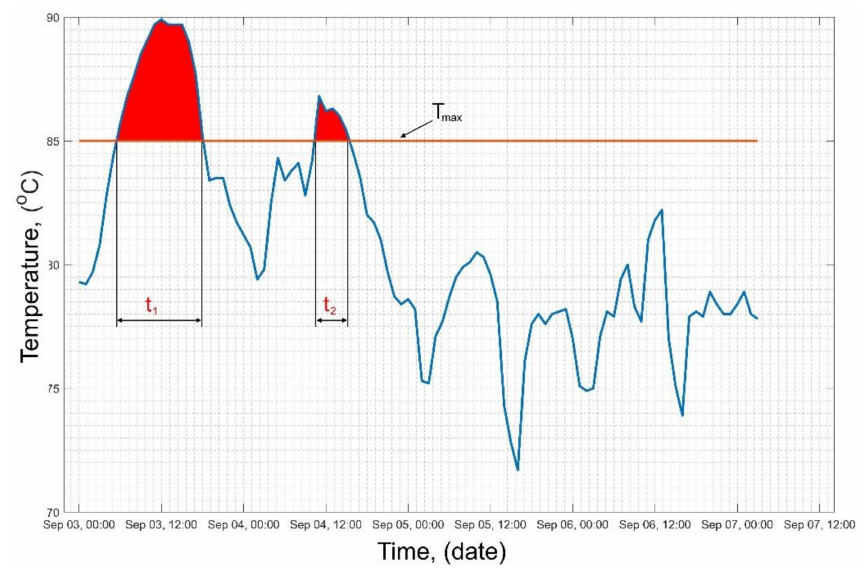
Figure 6. Schema of the idea of cumulative minimum time of the temperature